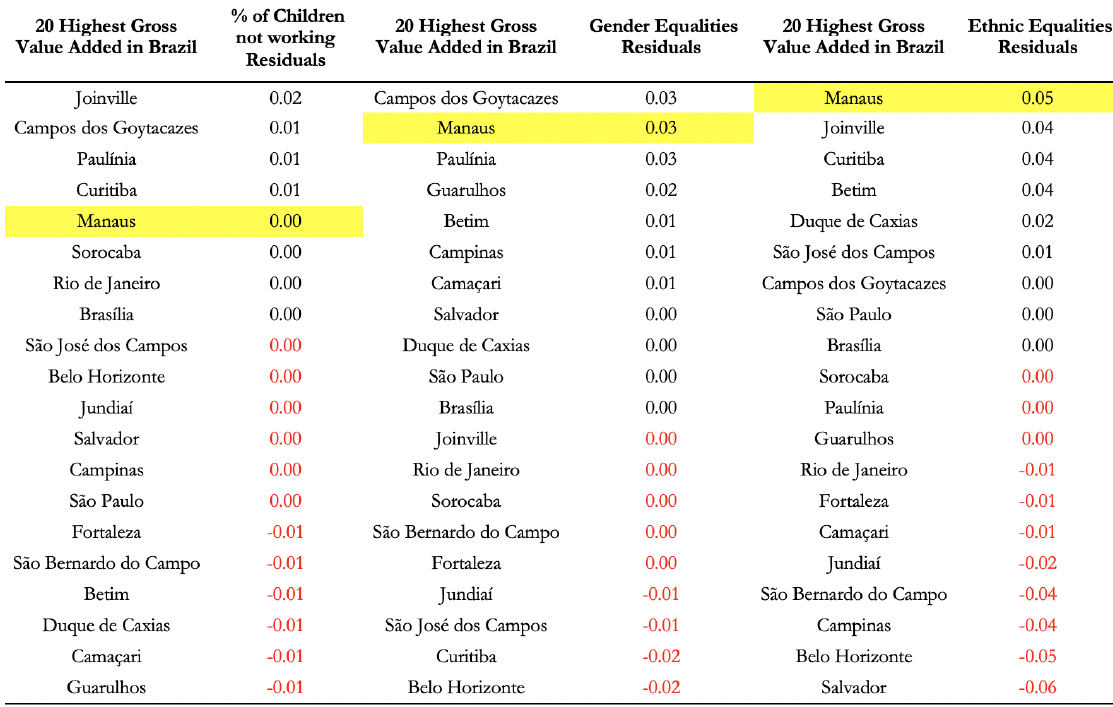
Table 11: Ranking of Labor Standards Residuals (Model A) - per 20 municipalities with the highest industry Gross Value Added in Brazil, per variable